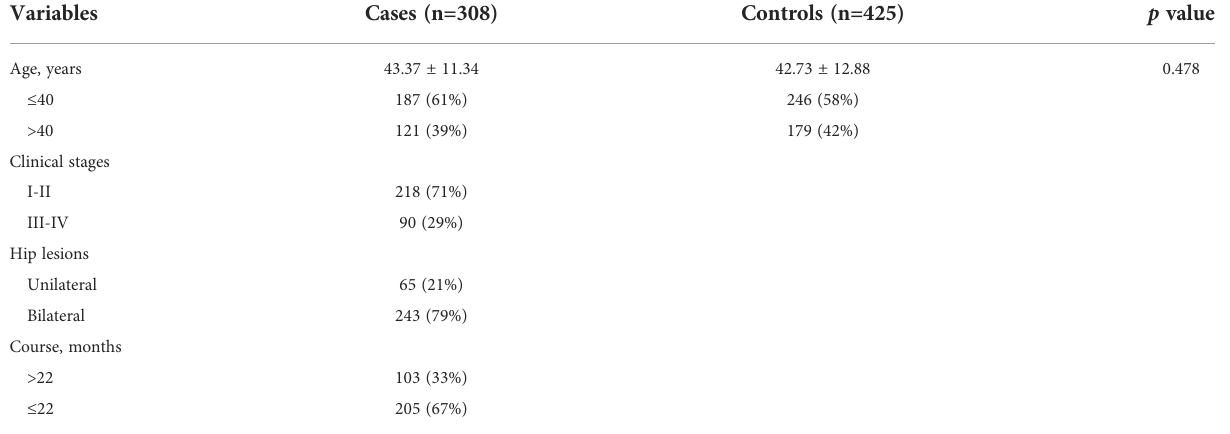
TABLE 1 Characteristics of ONFH patients and controls in this study.